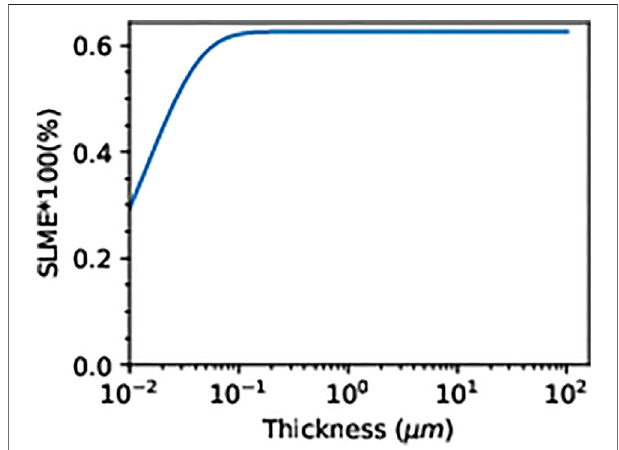
FIGURE 5 | Spectroscopic limited maximum ef fi ciency of CH 3 NH 2 CH 3 PbI 3 at 293.15